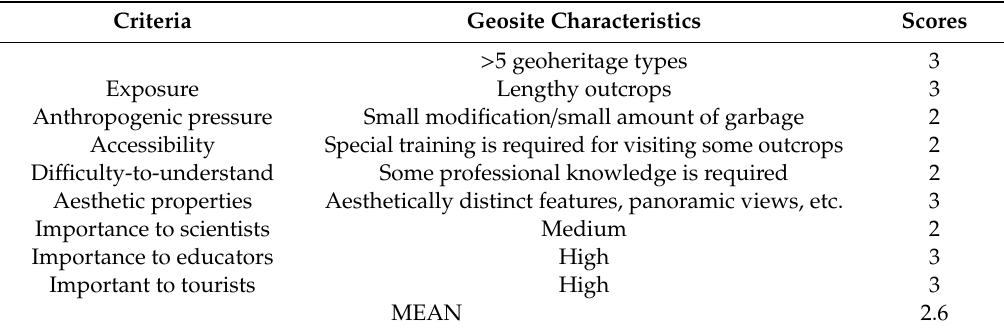
Table 2. The Khadzhokh Canyon System geosite